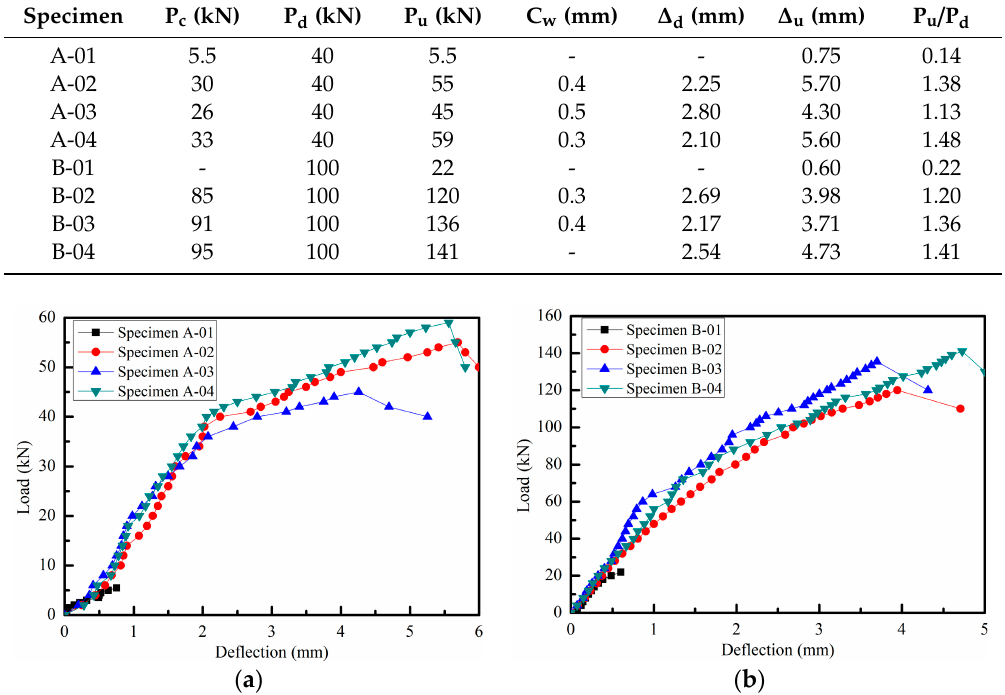
Table 2. Test results of the mechanical properties of different specimens.